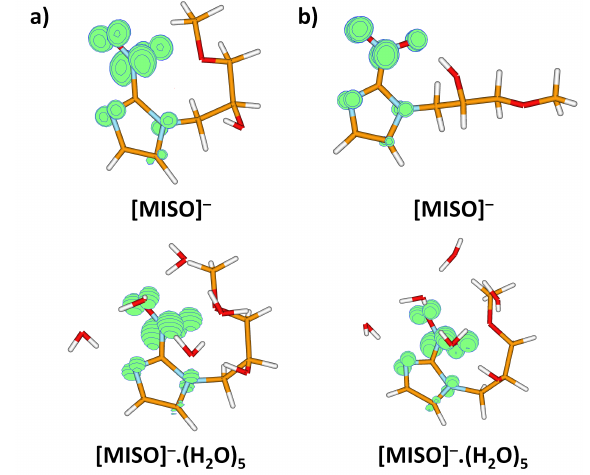
Figure 5. Spin density for the misonidazole anion ( a ) in the structure of the neutral molecule; ( b ) for the minimum located after optimization in the anionic state. Both MISO − and MISO − .(H 2 O) 5 were considered. Calculated at the B3LYP+D2/aug-cc-pVDZ